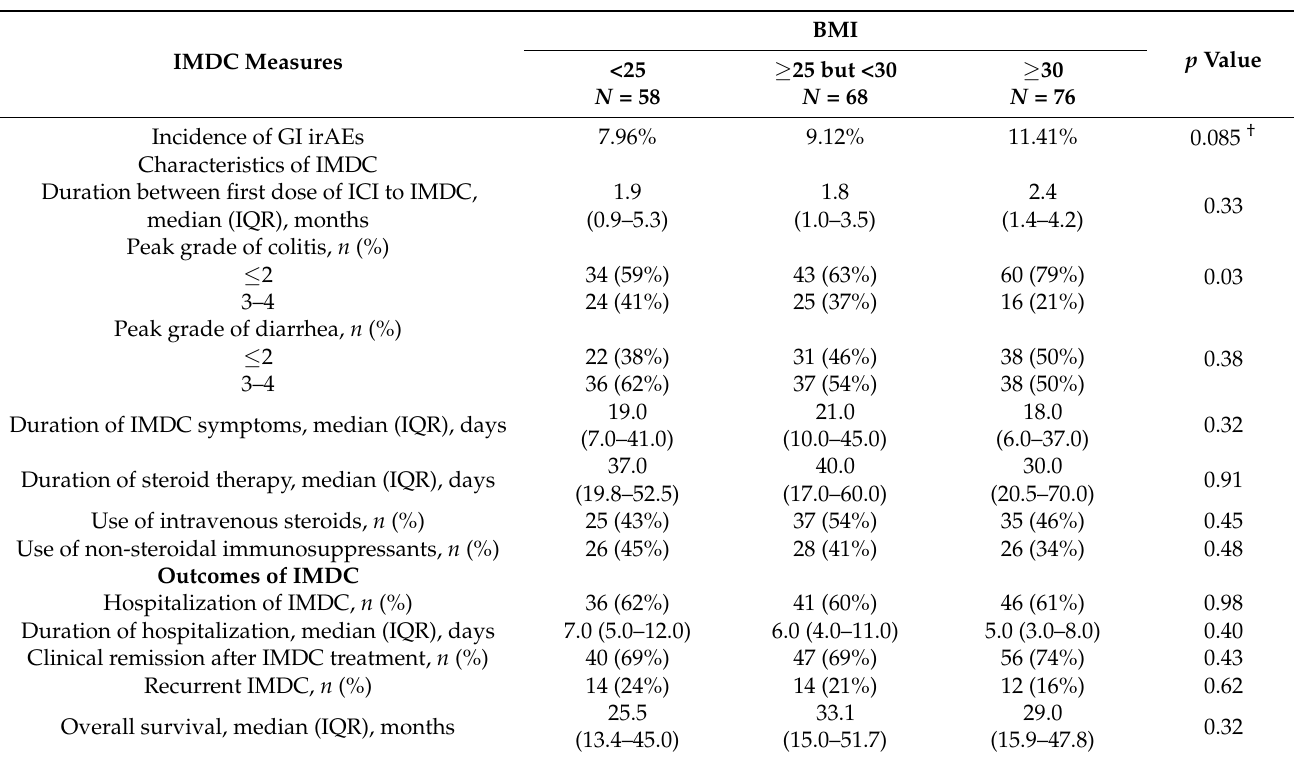
Table 2. Characteristics and outcomes of IMDC stratified by